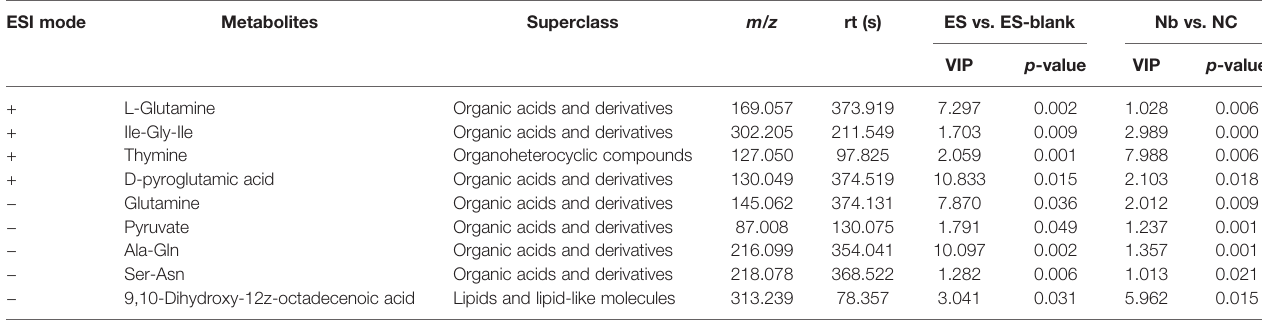
TABLE 1 | List of the common differential metabolites in Nb vs. NC and ES vs. ES-blank. ESI mode